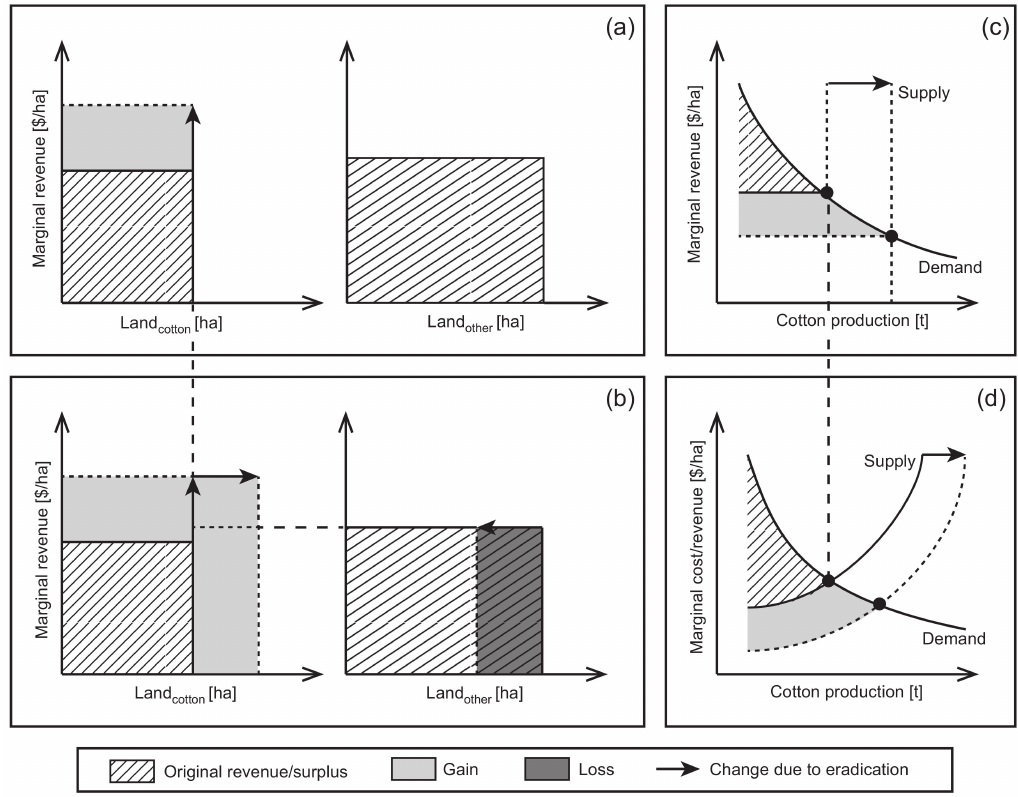
Figure 3. Differences in economic impacts: ( a ) farm budgeting, ( b ) linear programming, ( c ) surplus analysis, and ( d ) agricultural sector